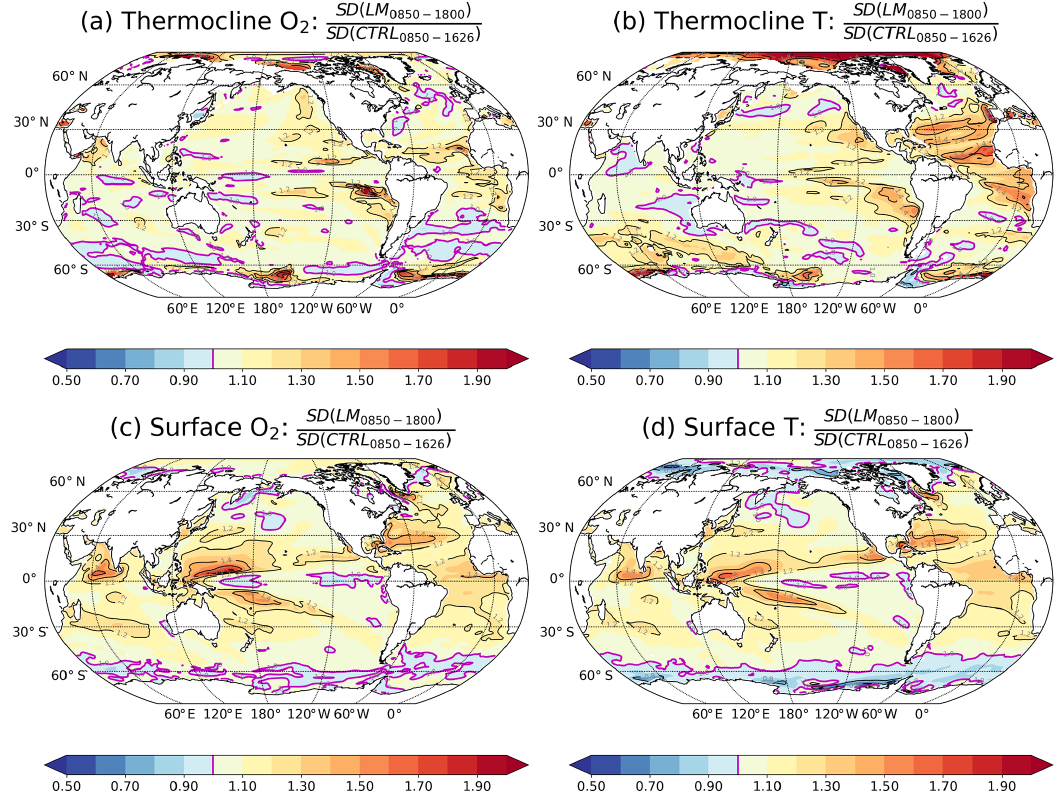
Figure 4. Ratio of the SDs from the forced simulation (850–1800CE) versus those from the control simulation (CTRL) for O 2 (left column) and T (right column) for (a, b) the thermocline (200–600m) and (c, d) the surface. The magenta contours highlight the ratio equal to 1, i.e. where SDs are equal in the forced and control simulation. SDs are computed from annually (all panels) and vertically (panels a – b ) averaged